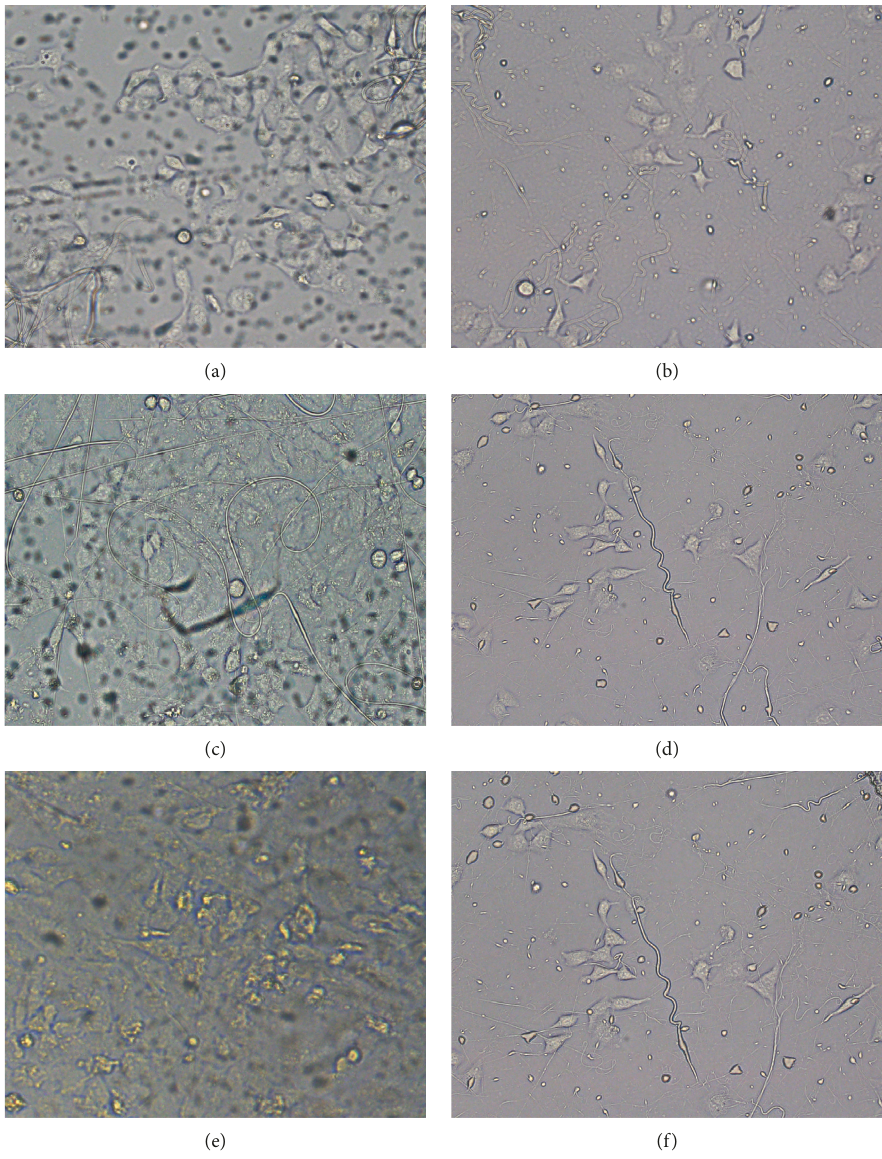
Figure 5: Inverted microscopy images of A549 lung cancer cells grown onto GO/PLA/PBC nanofibers without drug-loaded Typhonium giganteum (a, c, e) and with drug-loaded Typhonium giganteum GO/PLA/PBC nanofibers (b, d, f) after 1 (a, b), 3 (c, d), and 7 days (e,